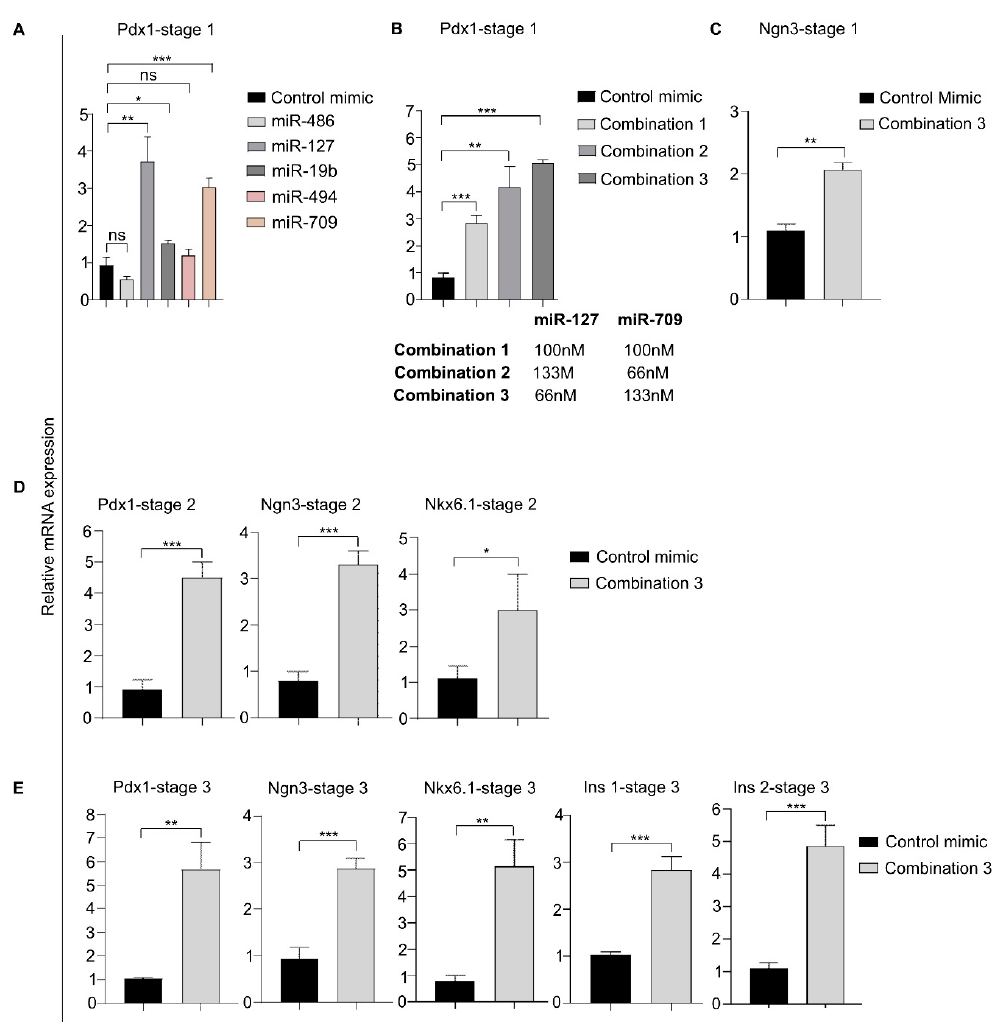
Figure 7. Exogenous addition of upregulated miRNAs to differentiate MEFs into β -like cells. ( A ) Pdx1 gene expression in stage 1 cells after individual transfection with the upregulated miRNAs. ( B ) Assessment of how different miR-127 and miR-709 combinations induce Pdx1 expression in stage 1 cells. ( C ) Ngn3 transcript levels were identified in stage 1 cells after miR-127 and miR-709 transfection using combination 3. ( D ) Pancreatic gene expression profile (qRT-PCR) in stage 2 cells transfected with miR-127 and mir-709 (combination 3). ( E ) qRT-PCR analysis of pancreatic β -cell markers in stage 3 cells transfected with miR-127 and miR-709 (combination 3). * p < 0.05, ** p < 0.01, and *** p < 0.001. Statistical significance was determined by paired, two-tailed t -testing. The data shown represent the mean ± SEM of three independent experiments. Ins1 = Insulin-1, Ins2 = Insulin 2, and ns = non- significant. Stage 1, and 2 media consisted of basal medium + stage 1, and 2 small molecules. Stage 3 medium comprised of basal medium + stage 3 small molecules, growth factors and supplements. Because the highest Pdx1 transcript level was expressed in stage 1 after miR-127 + miR-709 transfection (combination 3, Figure 7B), we checked whether any other pancreatic gene was induced as a result of the exogenous miRNA. Surprisingly, we detected Ngn3 expression (Figure 7C), though at a low level, in the stage 1 cells. No other pancreatic gene transcript could be detected in the qRT- PCR analysis (data not shown). Next, we explored the pancreatic gene expression pattern in stage 2 cells after transfection with miR-127 + miR-709 (combination 3). We found increased Pdx1, Ngn3, and